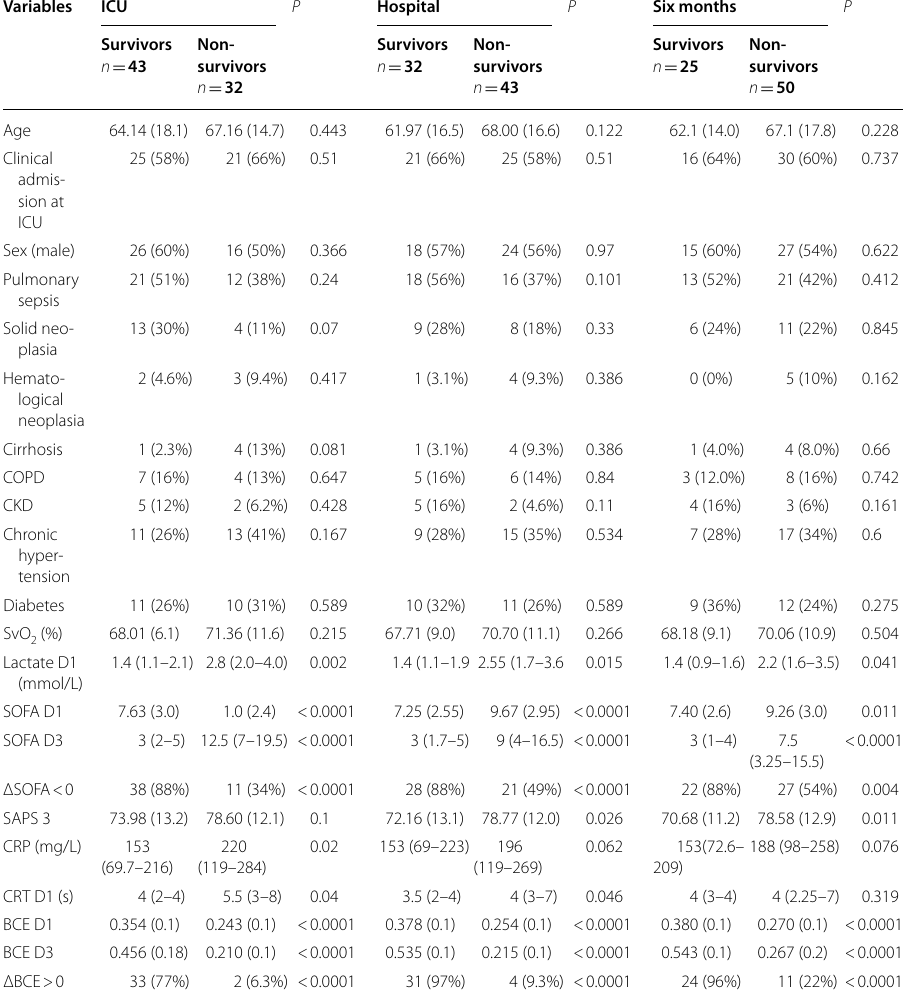
Δ indicates the pairwise variation between values obtained at day 3 and day 1, mathematically represented as day 3–day 1 for the indicated variable. Data are mean (SD), median (IQR), or n (%). CRP C-reactive protein, SOFA sequential organ failure assessment, ICU intensive care unit, SAPS 3 simplified acute physiology score 3, BCE biochemical coupling efficiency, COPD chronic obstructive pulmonary disease, CKD chronic kidney disease, CRT cardiac resynchronization therapy